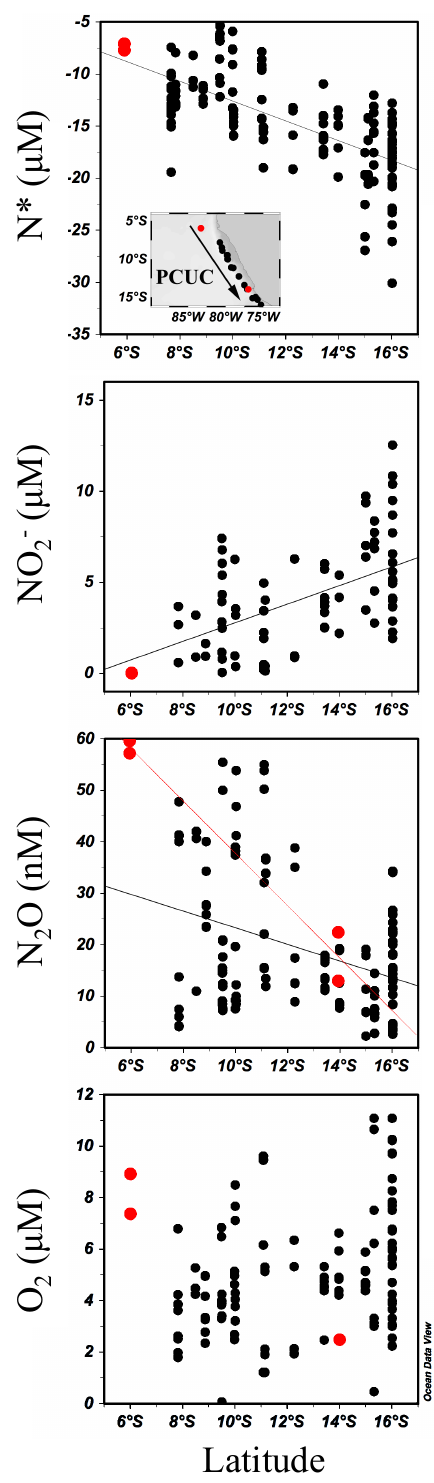
Fig. 4. Concentrations of NO − , O 2 , N 2 O, and N* in the Peru-Chile 2 Undercurrent (PCUC) in February 1985 (black) and February 2009 (red) between 26.3–26.5 σ θ . Black and red lines are the least squares line for 1985 and 2009 data, respectively. The insert shows the sta- tion locations and the direction of flow for the